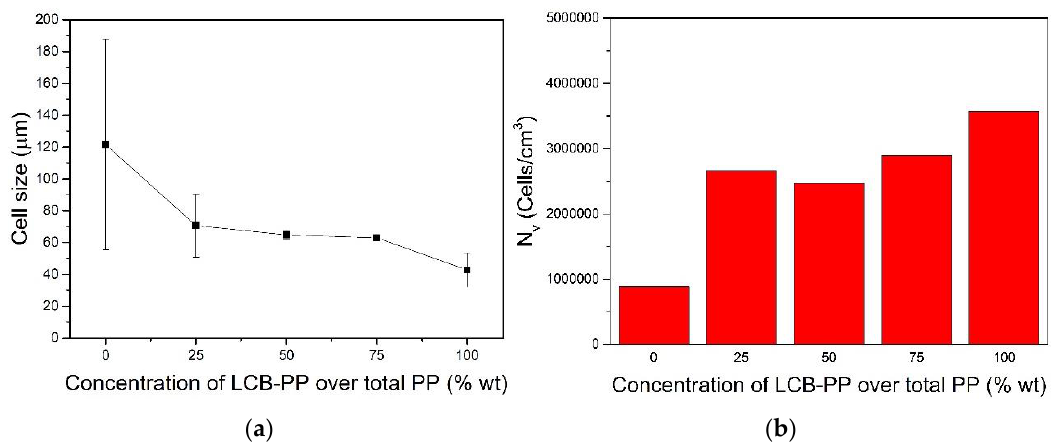
Figure 3. ( a ) Cell size and ( b ) cell density as a function of LCB-PP concentration. Polymers 2020 , 12 , x FOR PEER REVIEW